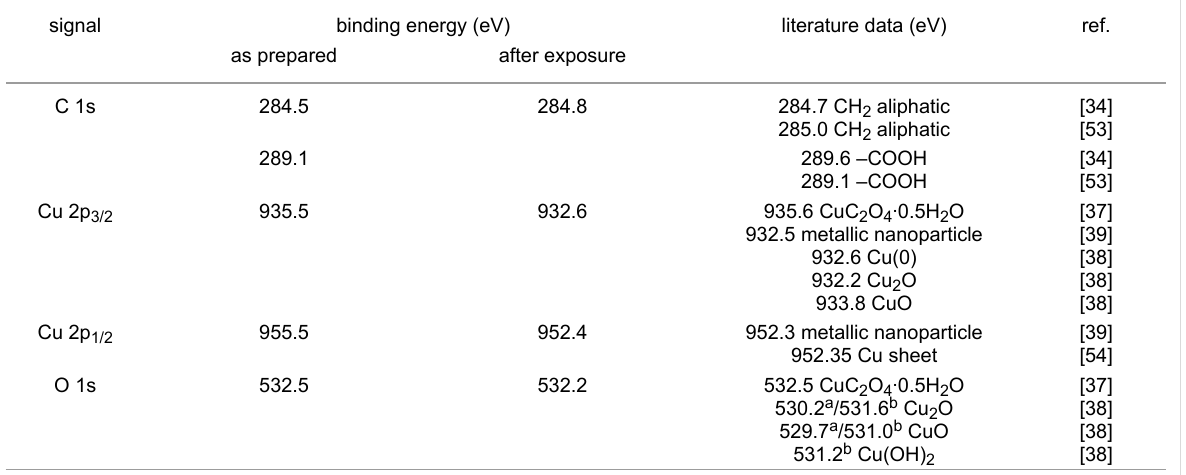
Table 1: XPS data obtained before and after in situ electron exposure of 16000 μ C/cm 2 at 50 eV of a surface grown copper(II) oxalate prepared by performing four deposition cycles and comparison with literature data. signal binding energy (eV) literature data (eV) ref.